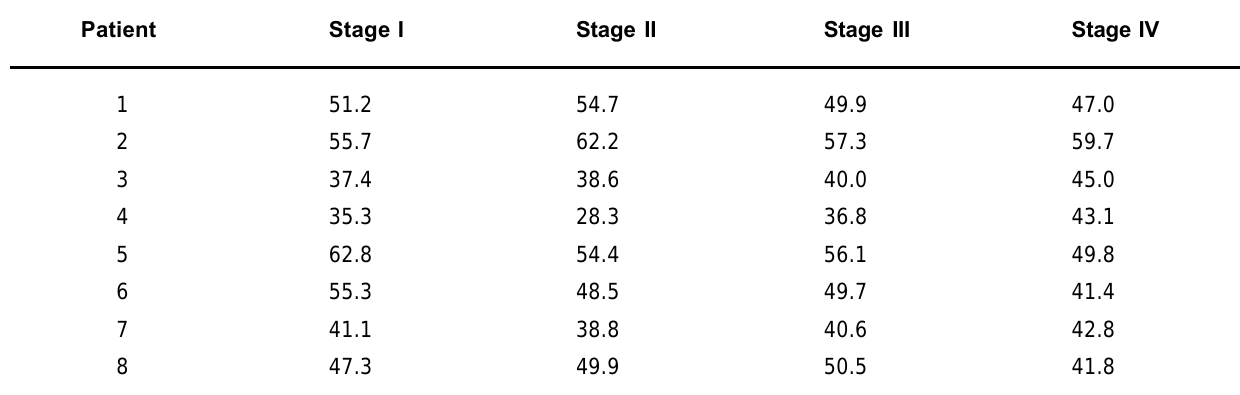
TABLE 10 - Mean distance (range of movement) between intercuspal position and maximum opening (in millimeters)